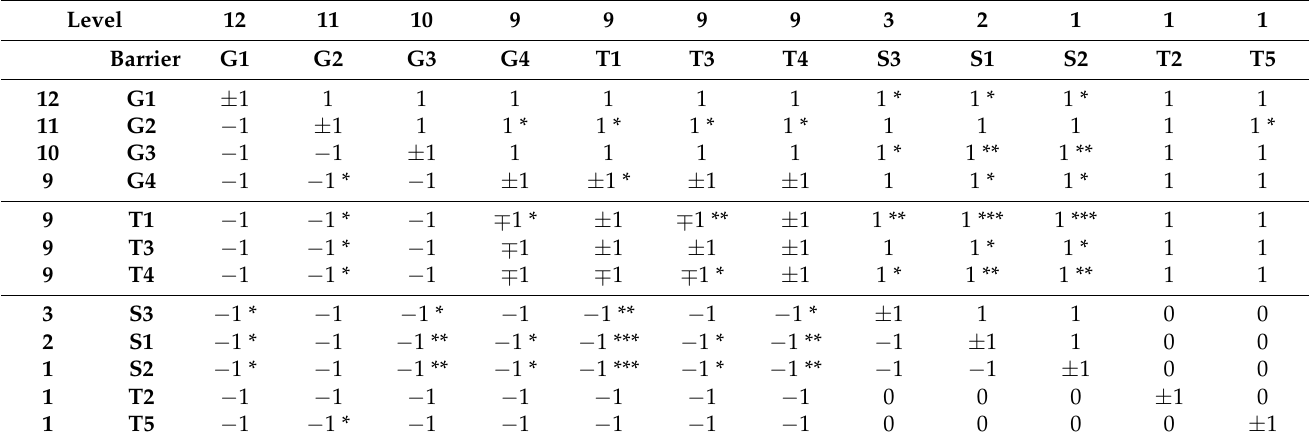
Table 9. Conical matrix (CM).